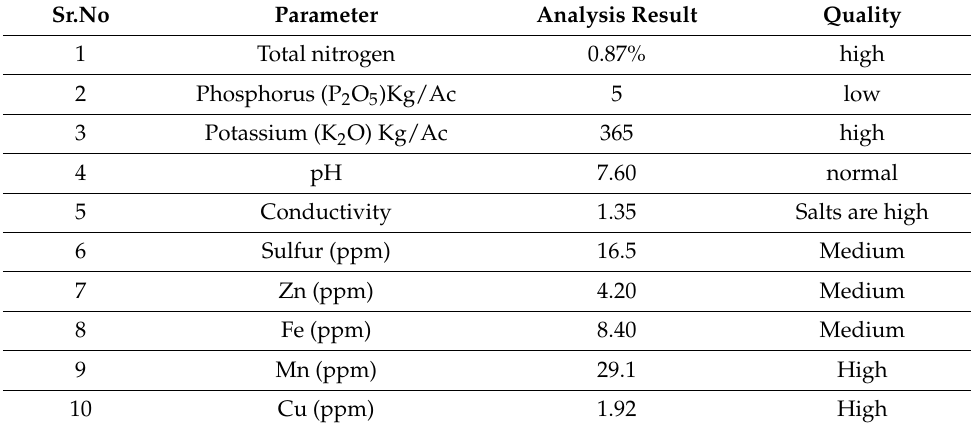
Table 1. Physico-chemical characterization of